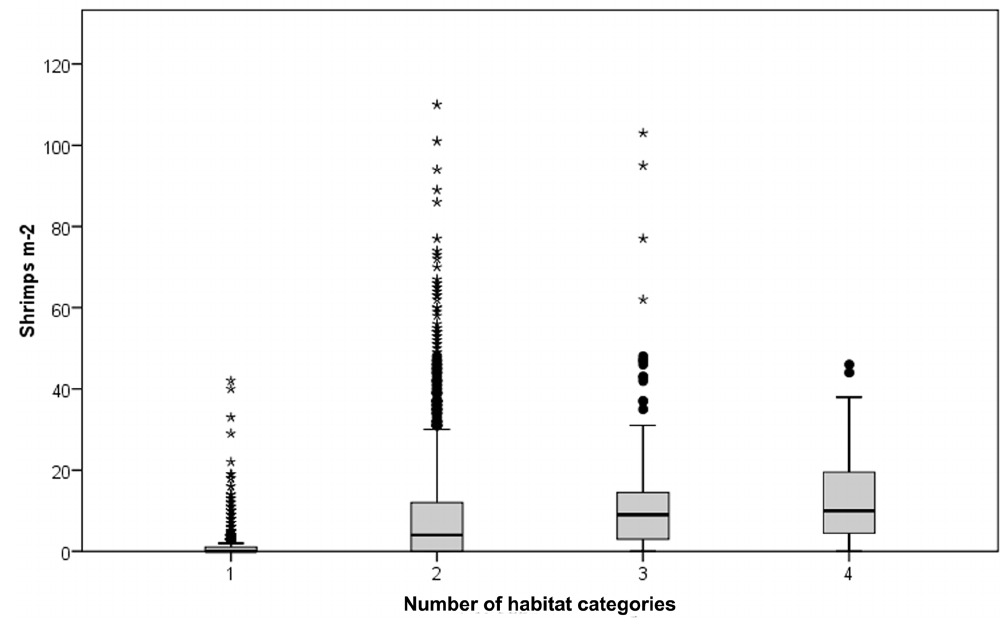
Fig. 7. Box plot showing shrimp densities observed in image frames with differing numbers of microhabitat categories